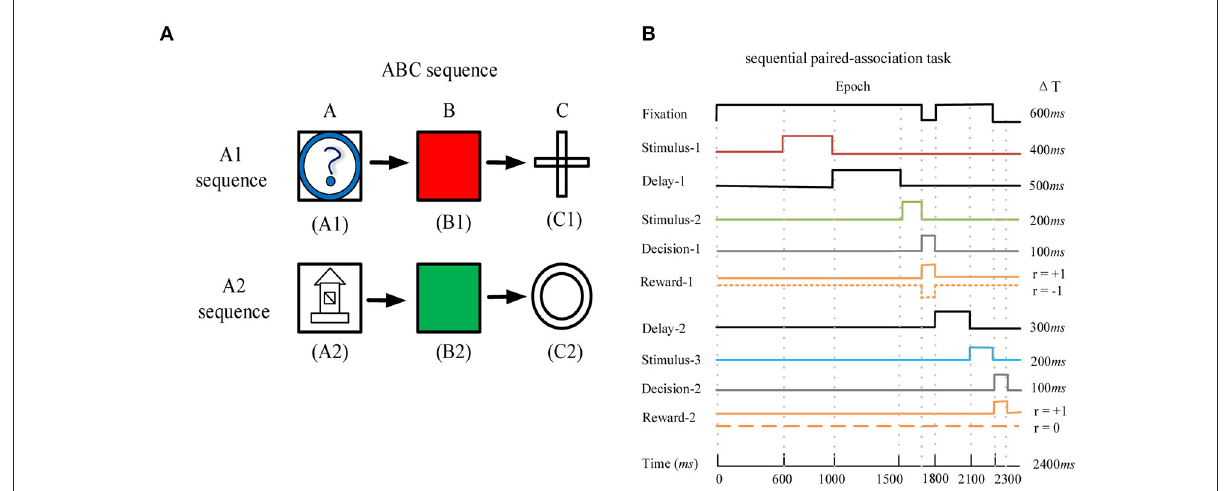
FIGURE2 The sequential paired-association task and its task events. (A) The example of the ABC sequence learned by the monkey. The two correct stimulus-stimulus associative sequences are A1 → B1 → C1 and A2 → B2 → C2. (B) Timing of task events in a trial of the sequential paired-association task. The network model needs to fixate on the fixation spot during the stimulus and delay periods. It obtains a positive reward r t + 1 = + 1 for each correct choice during the two decision periods (Decision-1 and Decision-2). If this model makes a wrong choice in the first decision period, it will obtain a negative reward r t + 1 = − 1 and the current trial is terminated. If this model makes a wrong choice in the second decision period, it will not obtain a reward ( r t + 1 = 0) and the trial will